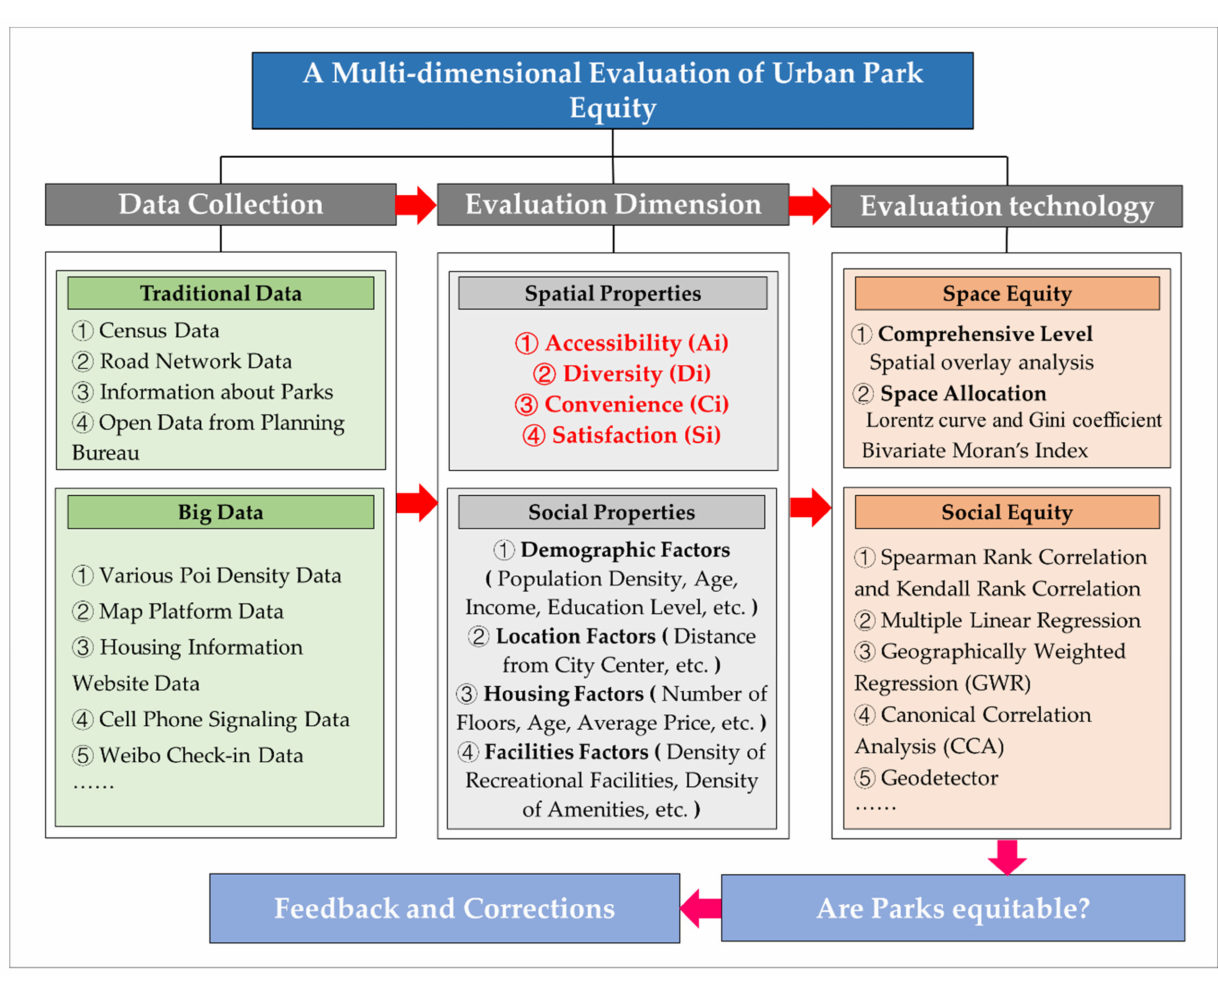
Figure 2. Multidimensional evaluation framework of urban park